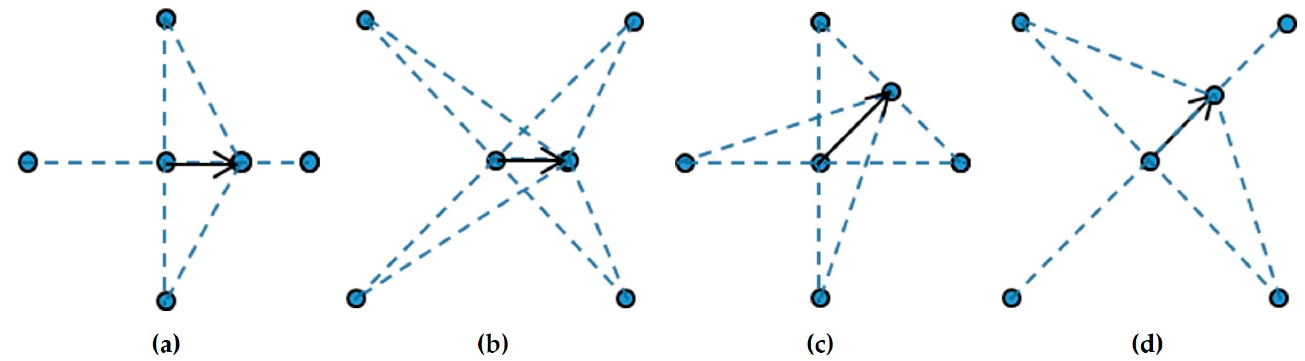
Figure 4. Schematic diagram of the verification process: ( a ) schematic diagram of the lateral change in the bending spring, ( b ) schematic diagram of the lateral change in the reinforcing spring, ( c ) schematic diagram of the change in the bending spring at the upper right, and ( d ) schematic diagram of the change in the reinforcement spring at the top right.